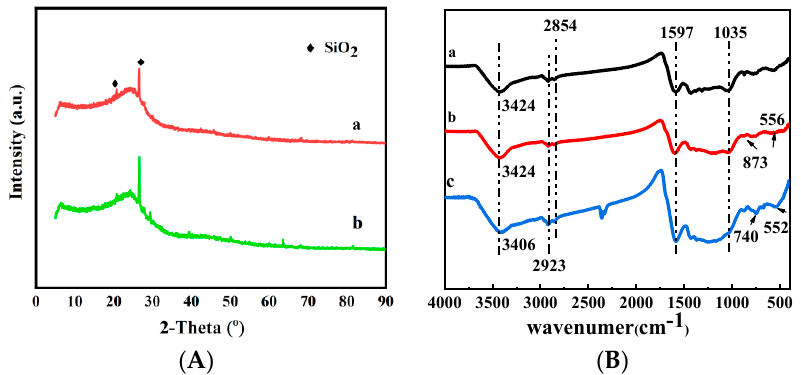
Figure 3. ( A ) The XRD patterns of (a) HDB and (b) MHDB; ( B ) FTIR spectra of (a) HDB, (b) MHDB; (c) MHDB after adsorption of Cr(VI).